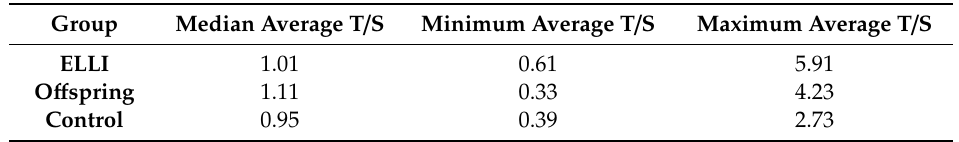
Table A5. Distribution of average T / S